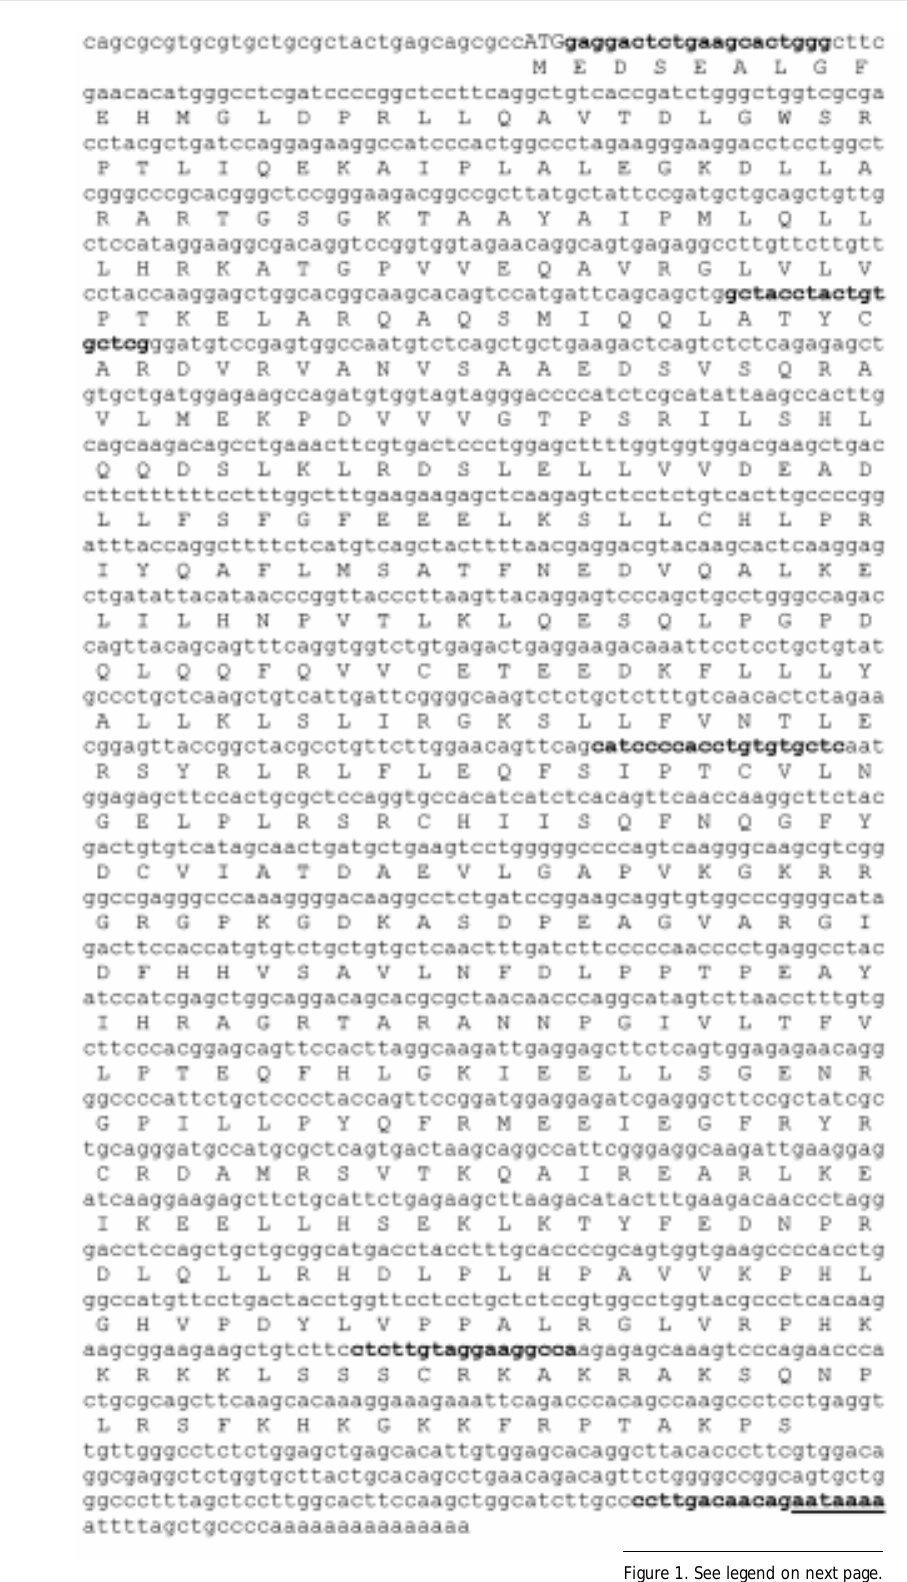
Figure 1. See legend on next